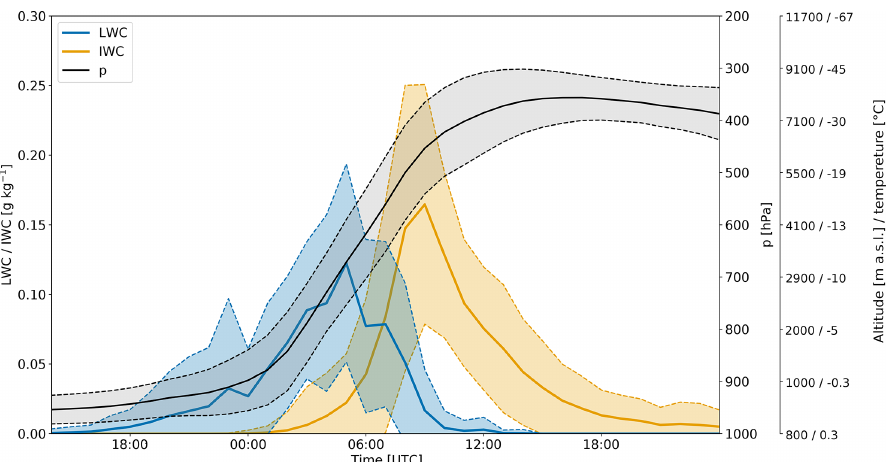
Figure 4. Temporal evolution of LWC (blue line; in grams per kilometre) and ice water content (IWC; yellow line, in grams per kilome- tre) from IFS analyses along the WCB trajectories (black line and grey shading represent the pressure level of the selected trajectories in hectopascals) shown in Fig. 3. Shown are the mean (solid lines) and the standard deviation (dashed lines and shading). The altitudes and temperatures of the pressure levels (second y axis on the right) are taken from the radiosounding at